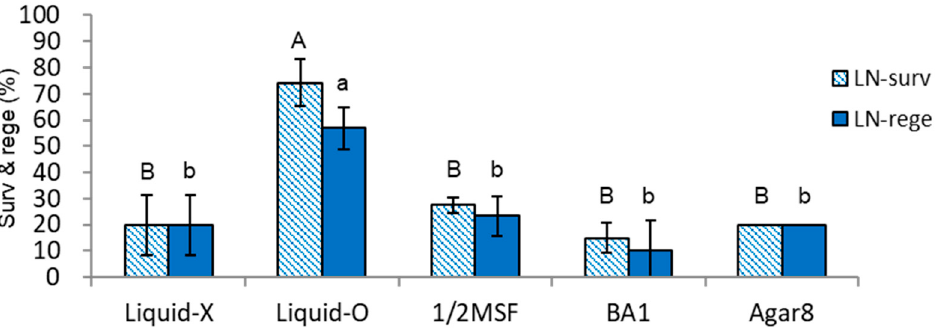
Figure 4. Effect of subculture medium and supplements on LN-survival (surv) and regeneration (rege) of P. yatabeanus shoot tips in regrowth steps of RM2 (ammonium-containing medium)-RM2-MSF. Liquid-X: MSF, gellan gum 3.0 g L − 1 , Liquid-X; Liquid-O: MSF, gellan gum 3.0 g L − 1 , Liquid-O;